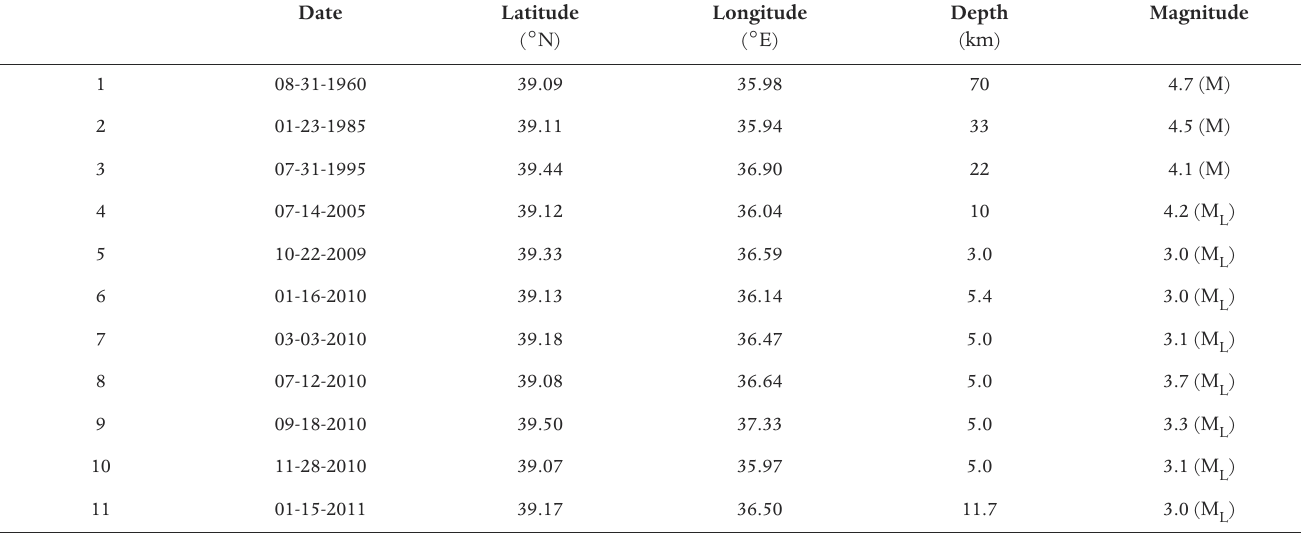
Table 1. Instrumental seismicity around Deliler Fault and Tecer Fault over the last 50 years [Kalafat et al. 2008]. These events are also plotted in Figure